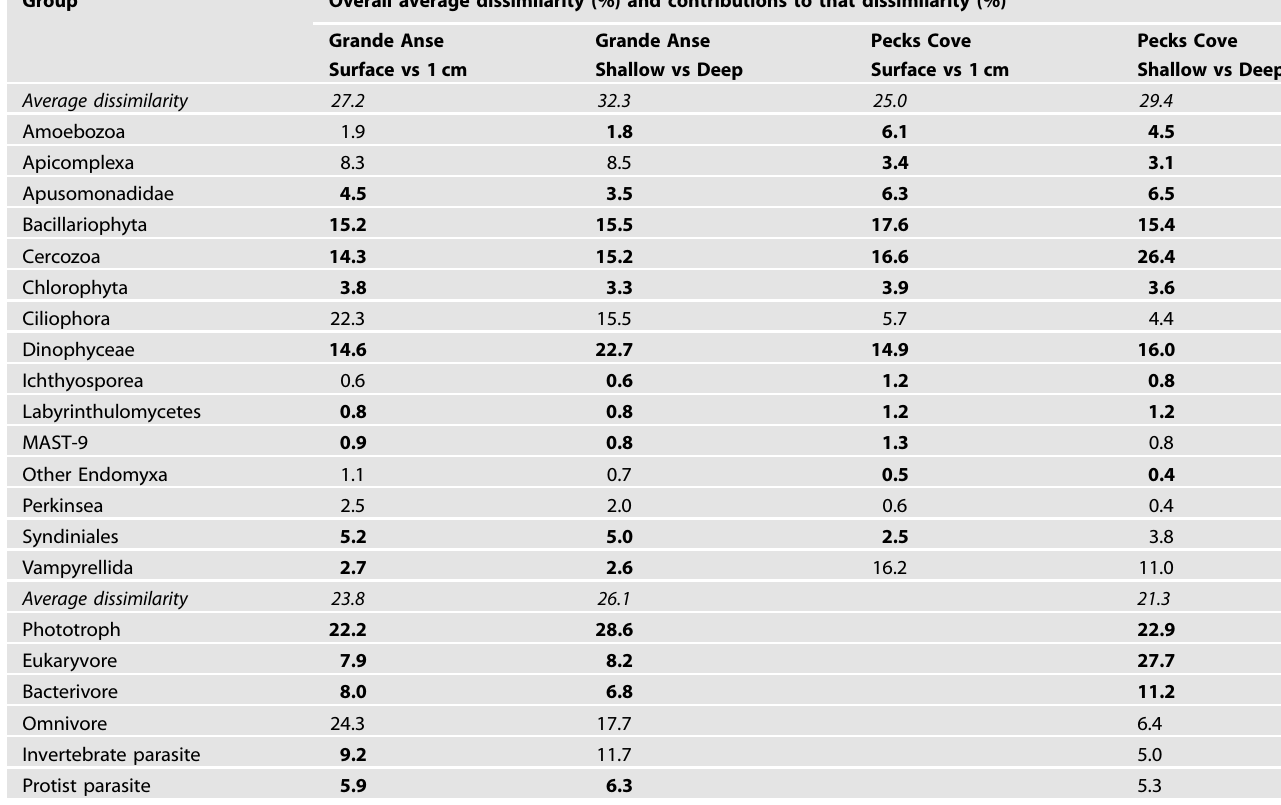
Table 2. SIMPER results showing the contributions of protist taxa and trophic functional subgroups to signi fi cant variations among depths or their seasonal patterns (see Table 1 and S7) in Bay of Fundy mud fl ats in